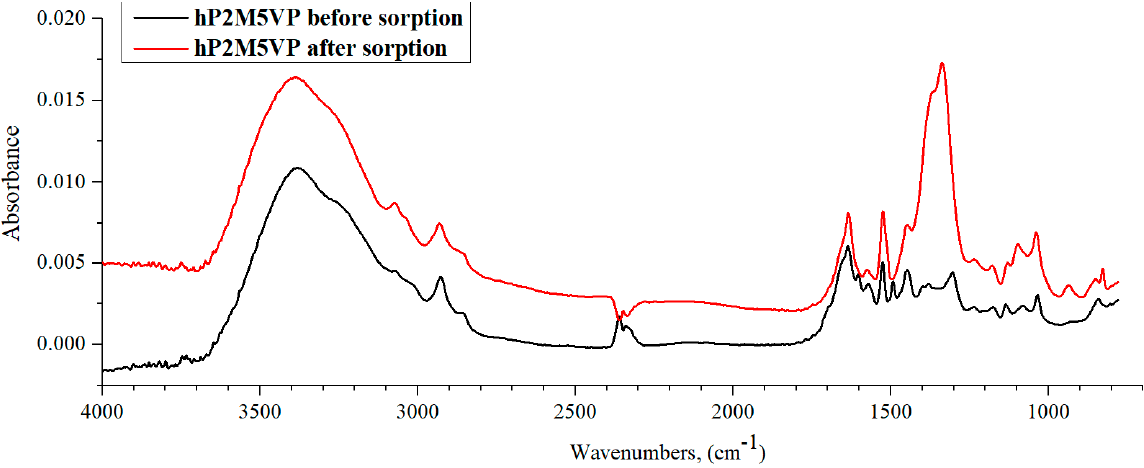
Figure 13. IR spectra of hP2M5VP before and after lanthanum sorption by interpolymer system 67%hPAA-33%hP2M5VP.